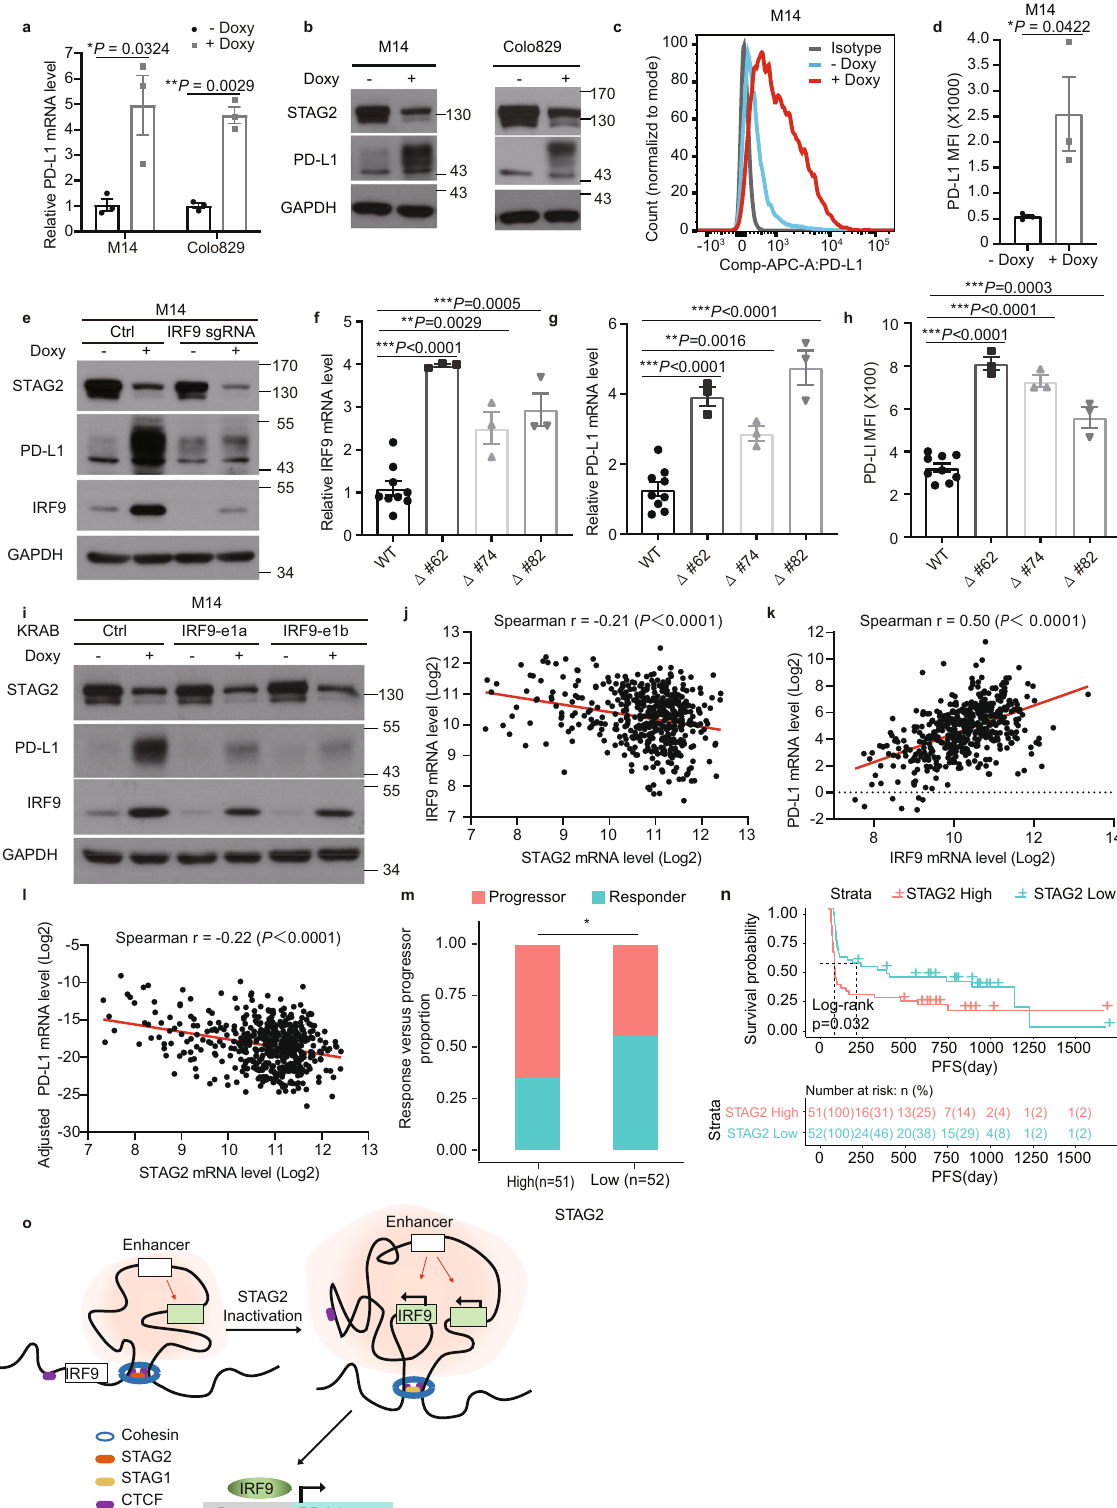
data. With this probability normalization, the genomic segments that are within the resolution of the Hi-C map along the sequence will on average have a contact probability of 1, which enables a direct comparison of the difference between the contact probability decay for STAG2 WT and KD cells. The average contact probabilities by compartments for STAG2 WT and KD cells were similarly normalized and compared 47 . We fi rst calculated the average Hi-C contacts for pairs of two genomic loci that are labeled by compartment types as A-A, A-B, and B-B,